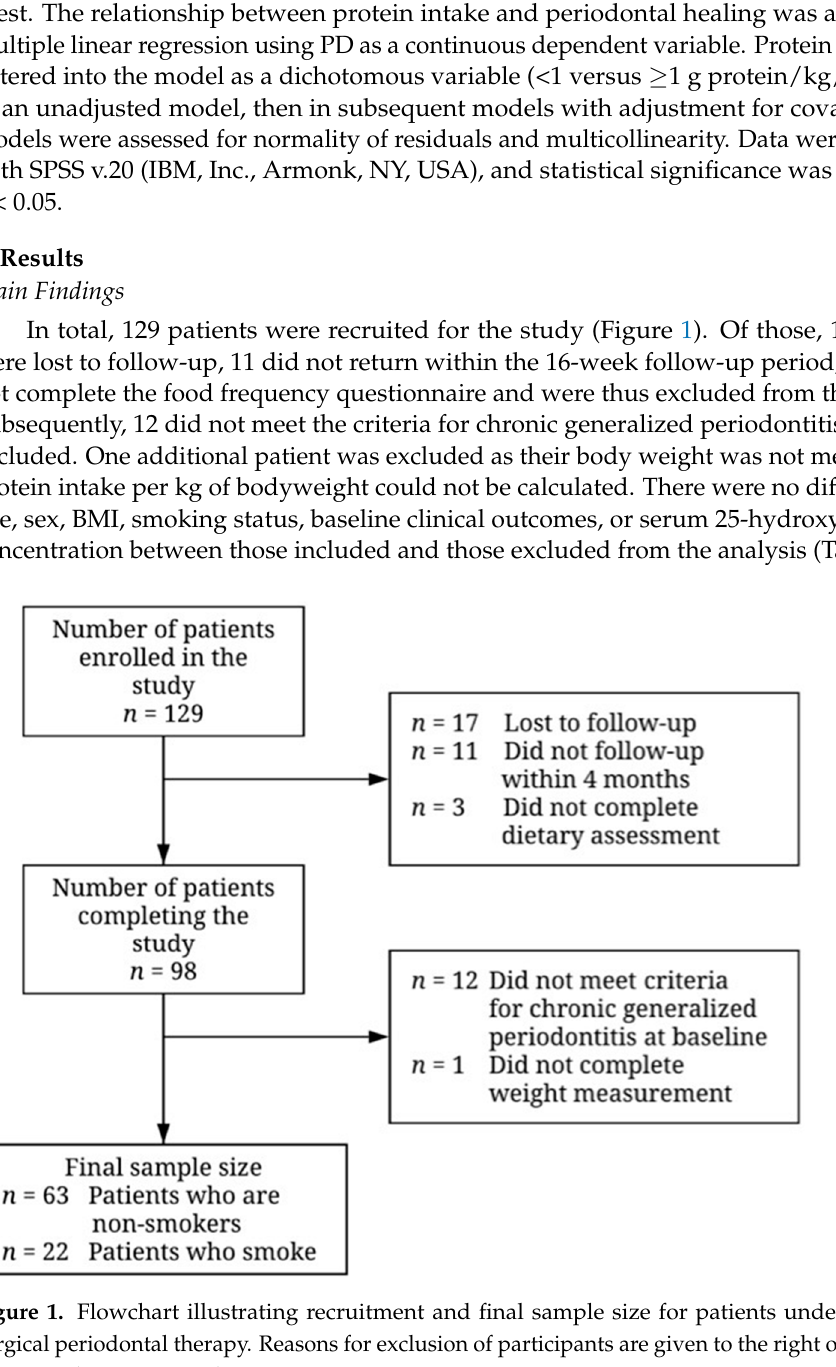
Table 3. Multiple linear regression of probing depth sites ≥ 4 mm after non-surgical periodontal therapy in patients who smoked 1 .